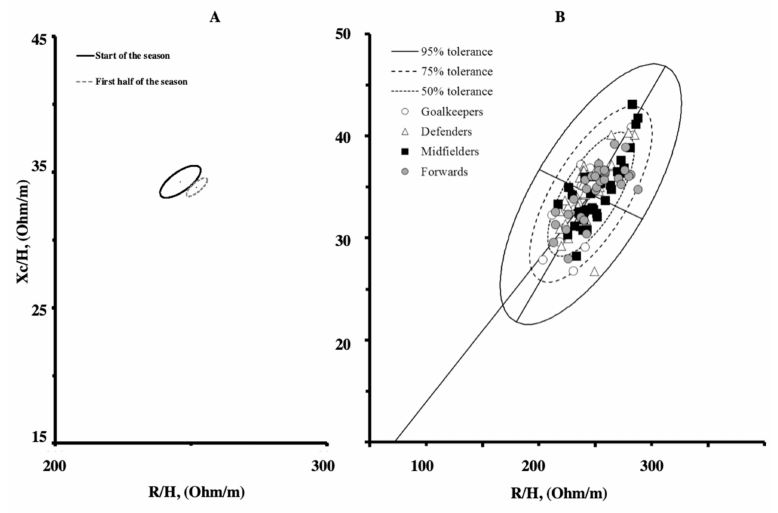
Figure 1. Mean impedance vectors with the 95% confidence ellipses for the soccer players measured at the start and at the first half of the competitive season [10] (Panel A ). Scattergrams of the individual impedance vectors plotted on the new tolerance ellipses (Panel B